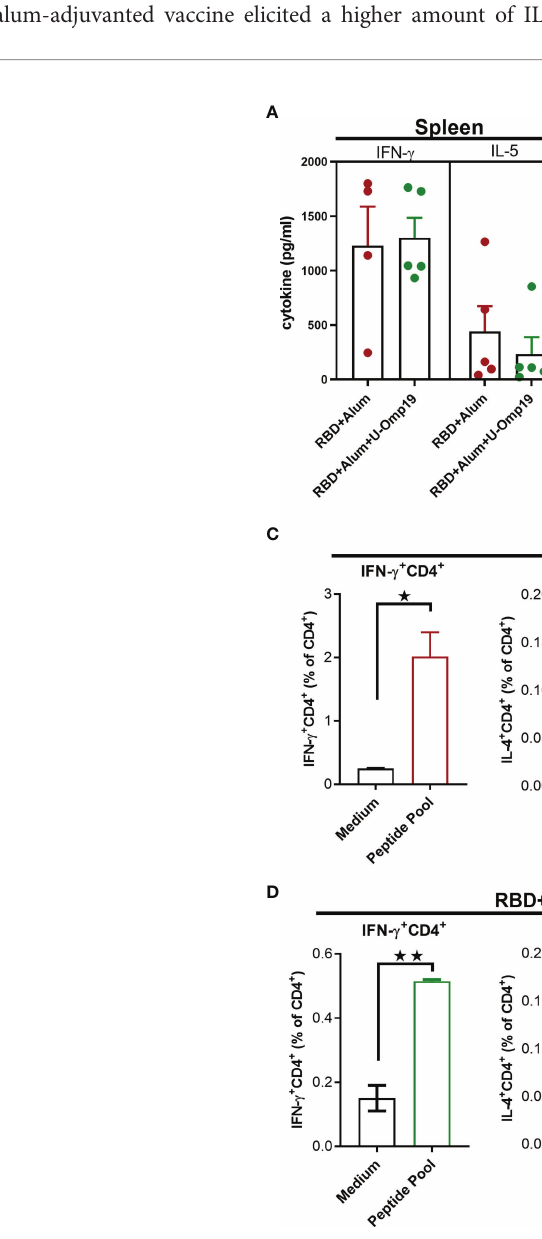
FIGURE 6 | U-Omp19+RBD+Alum formulation induces Ag-speci fi c Th1 and CD8 + T cells in the spleen and lung. BALB/c mice were vaccinated as described in Figure 2 . Mice were sacri fi ced 44 days after the fi rst immunization to obtain spleens and lungs, and T-cell response was evaluated. Levels of secreted IFN- g and IL- 5 following splenocytes (A) or lung cells (B) stimulation with medium or recombinant RBD were determined by ELISA. Bars are means ± SEM of pg/ml of IFN- g and IL-5 after subtracting the amount in medium stimulated cells. *p < 0.05, **p < 0.01. t-test. (C, D) Intracellular fl ow cytometry analysis of cytokine secreting T cells. Splenocytes from groups RBD+Alum (C) or RBD+Alum+U-Omp19 (D) were stimulated with complete medium or RBD-peptides pool for 18 h, and then, brefeldin A was added for 5 h. Afterward, cells were harvested and stained with speci fi c Abs anti-CD8, and anti-CD4, fi xed, permeabilized, and stained intracellularly with anti- IFN- g and anti-IL-4. Results are presented as percentage of IFN- g or IL-4-producing T lymphocytes. Bars are means ± SEM. *p < 0.05, **p < 0.01 vs. medium. t-test. Results are representative of two independent